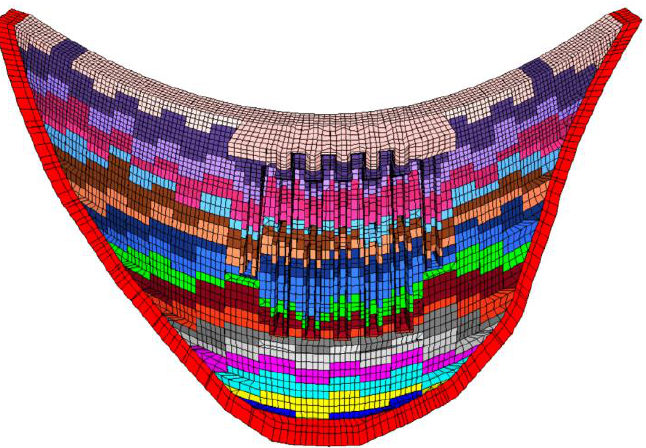
Figure 30. The finite element model for analysis of the dam-overhanging effect.